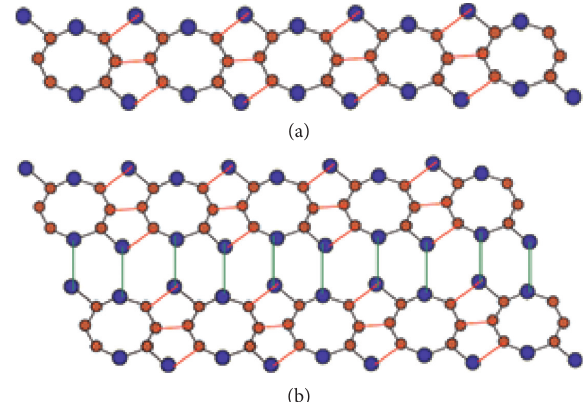
Figure 10: 2D structure of Si